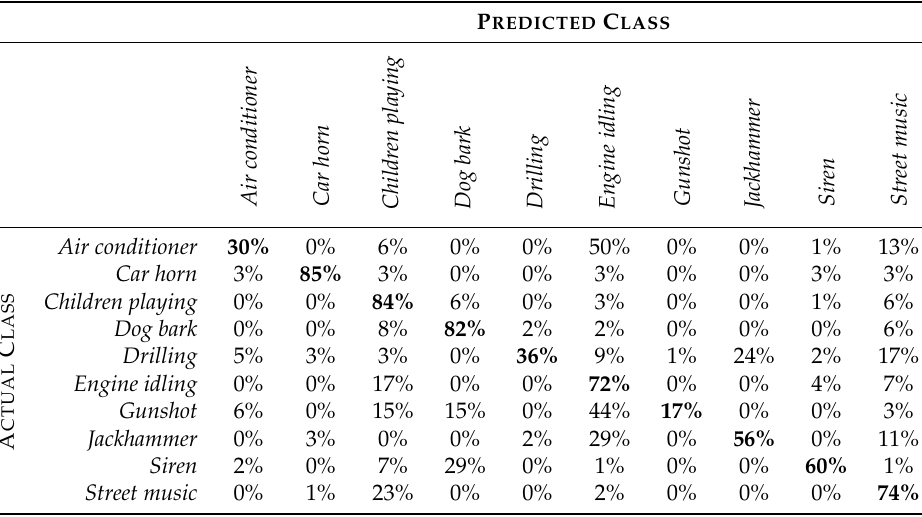
Table 3. Confusion matrix considering the classification of the modified audio files in a single